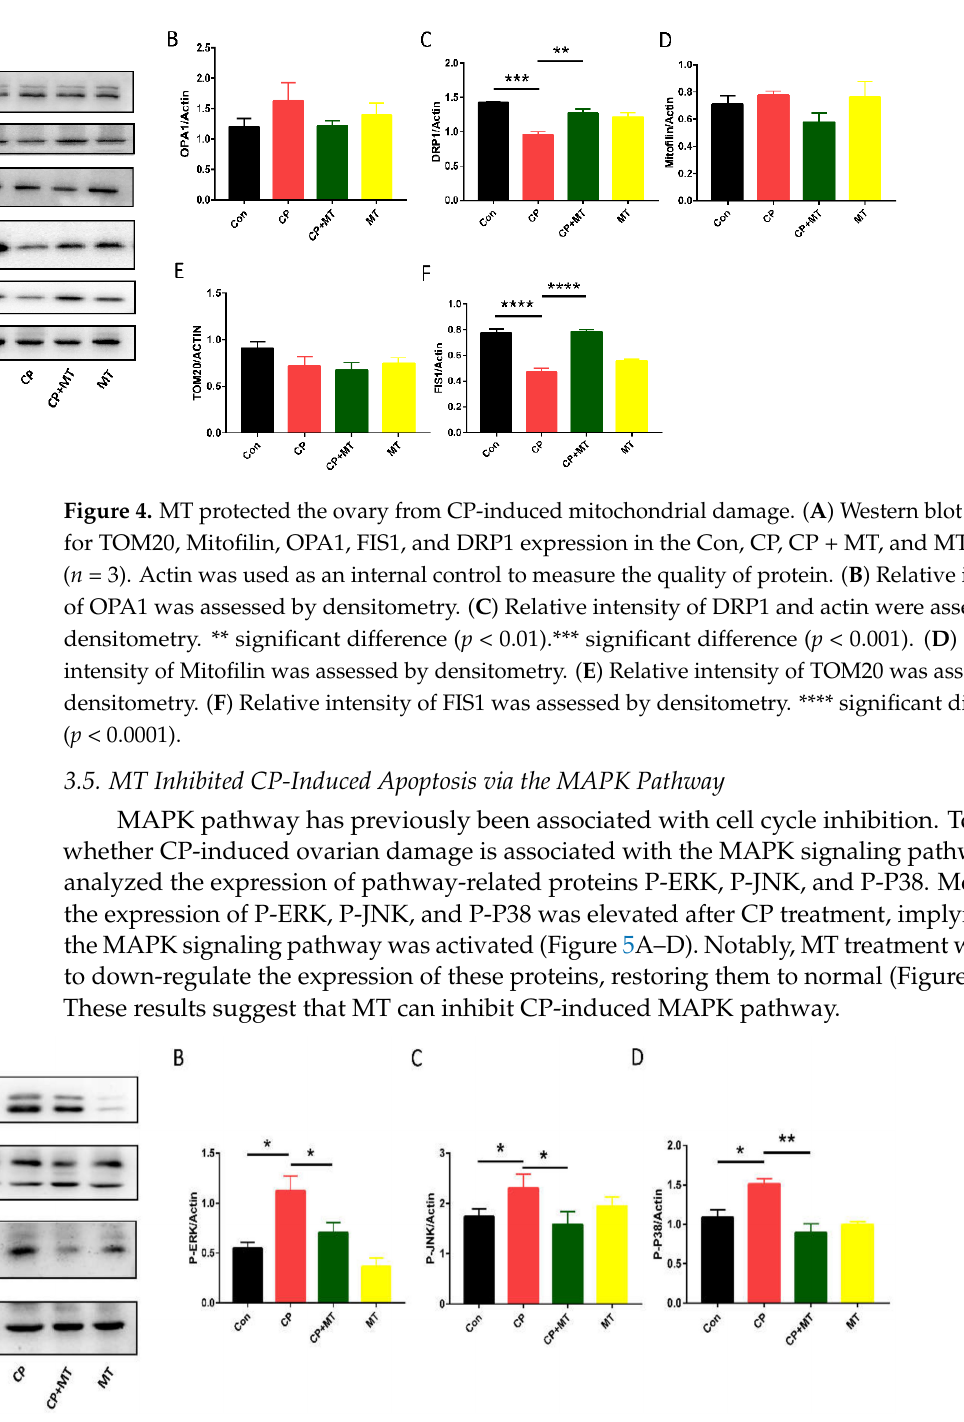
Figure 5. MT inhibited CP-induced MAPK pathway. ( A ) Western blot analysis for P-ERK, P-JNK, and P-P38 expression in the Con, CP, CP + MT, and MT groups ( n = 3). Actin was used as an internal control to measure the quality of protein. ( B ) Relative intensity of P-ERK was assessed by densitometry. *, significant difference ( p < 0.05). ( C ) Relative intensity of P-JNK was assessed by densitometry. * significant difference ( p < 0.05). ( D ) Relative intensity of P-P38 was assessed by densitometry. * significant difference ( p < 0.05), ** significant difference ( p <